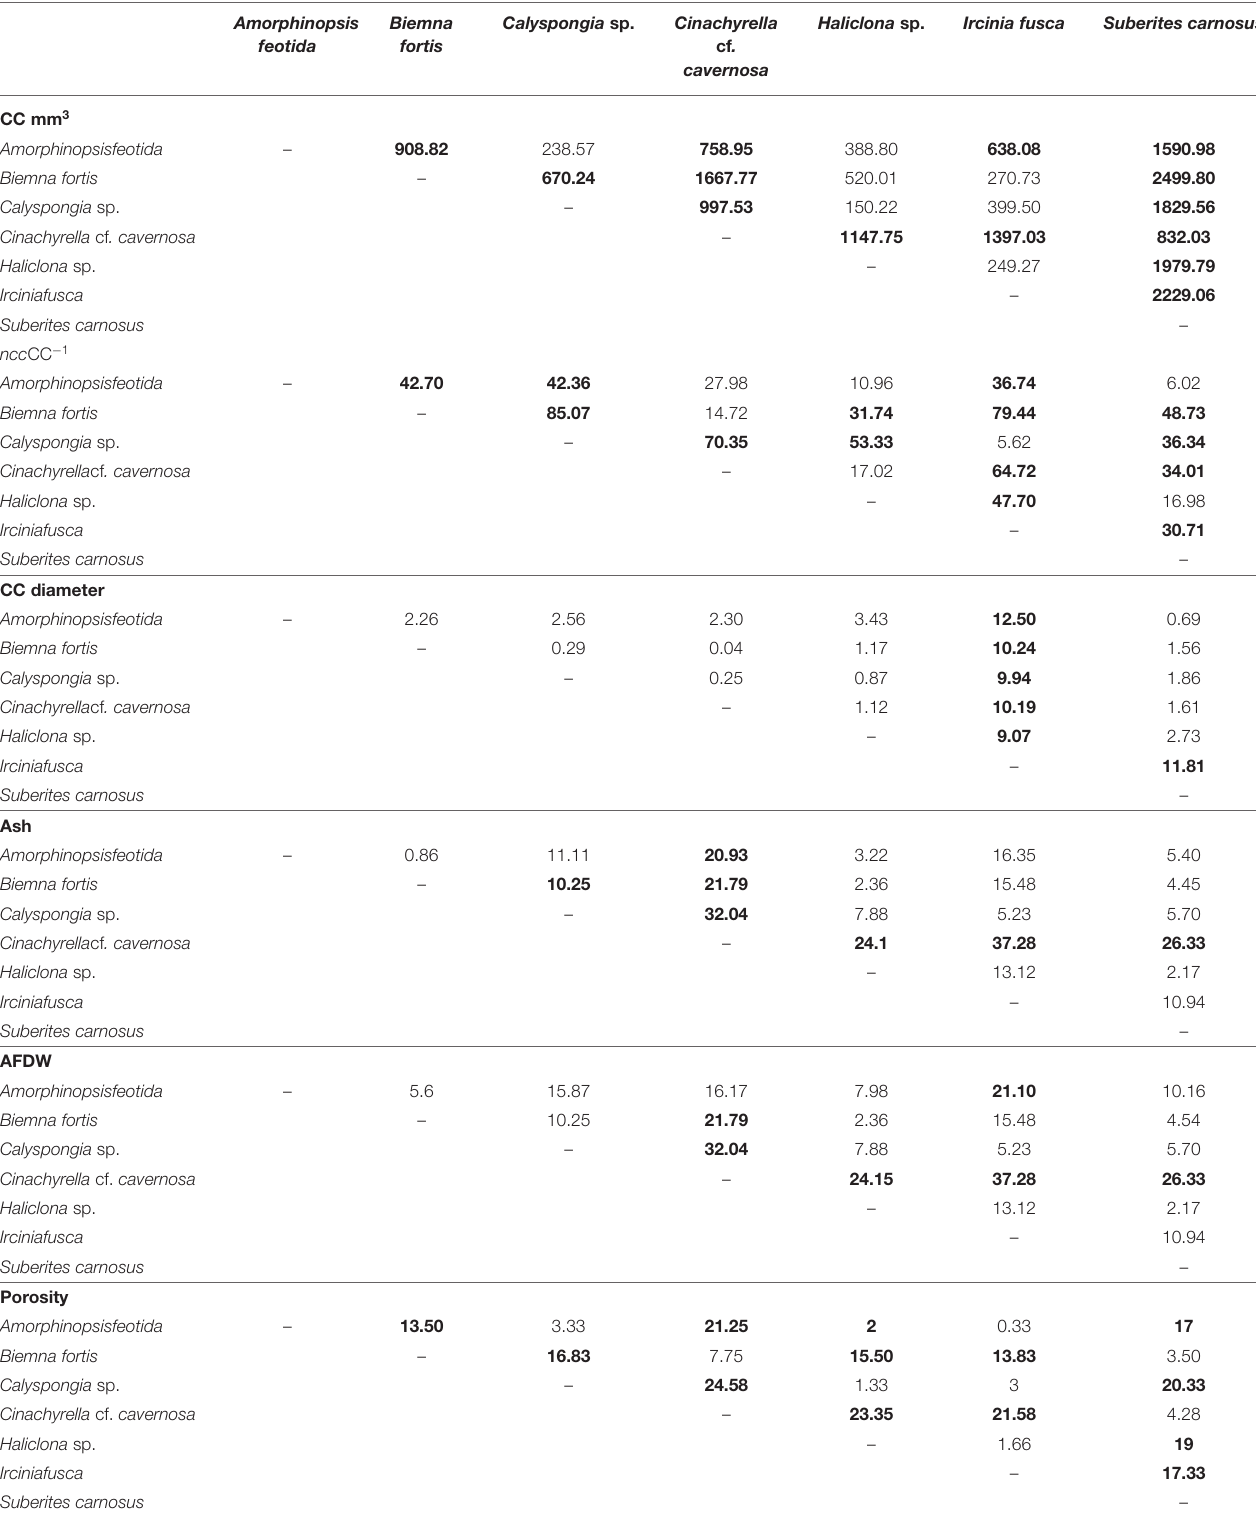
TABLE 4 | A pairwise comparison (Tukey test) of the mean differences between the sponge species with respect to the dependent variables: filtration apparatus (CC mm 3 , ncc CC − 1 , CC diameter) and structural components (ash%, AFDW%, porosity%, density, and spicule volume%). Amorphinopsis